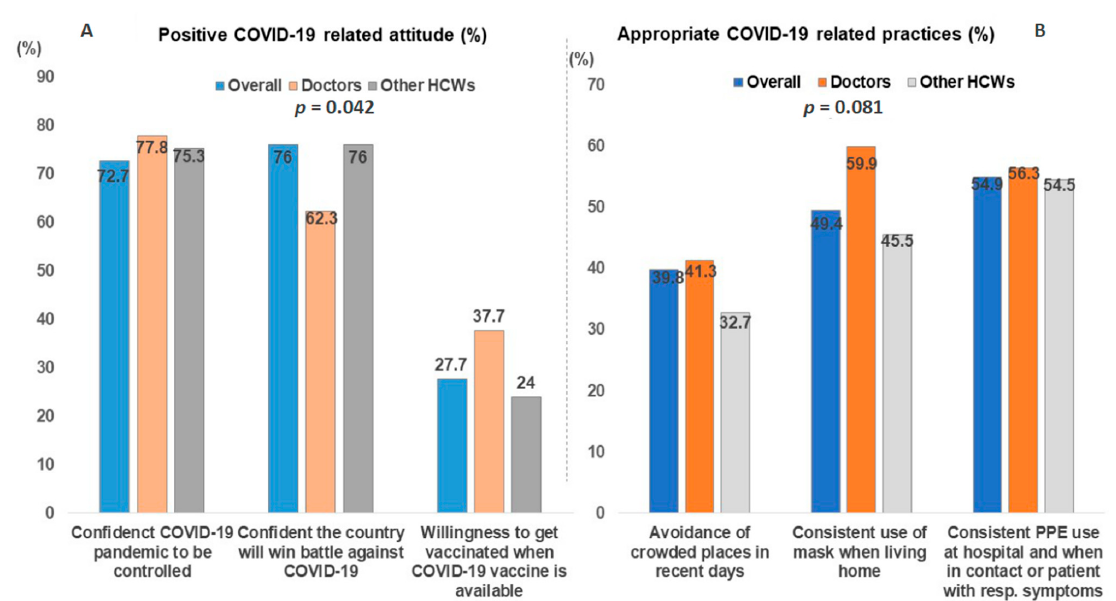
Figure 3. Attitudes and practices of the respondents towards COVID-19. ( A ) Proportions of participants with positive COVID-19-related attitudes; ( B ) Proportions of participants with appropriate COVID-19-related practices